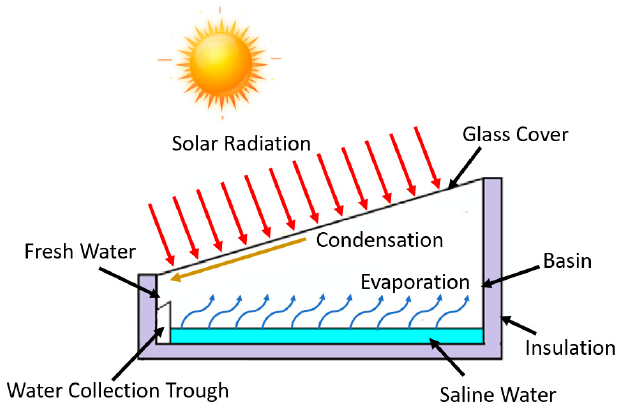
Figure 3. Heat transfer process in a solar still.